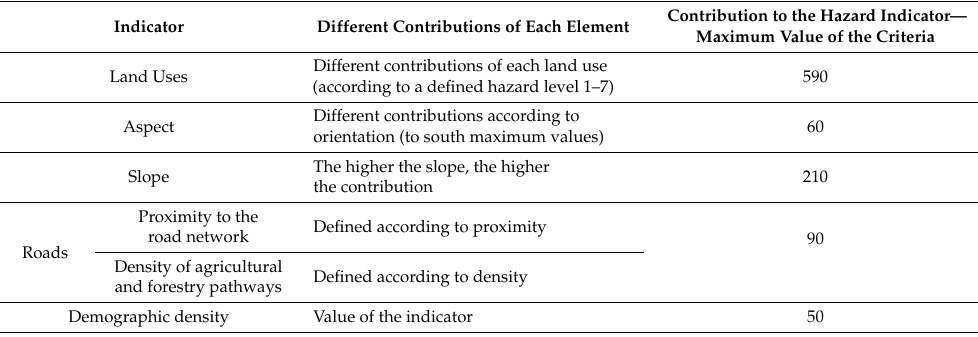
Table 1. Criteria used to build the Fire hazard (FR) indicator.